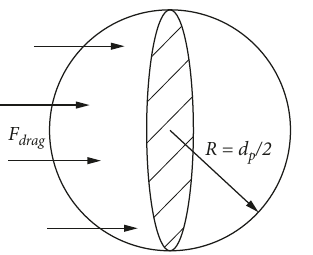
Figure 9: Schematic diagram of proppant stress.